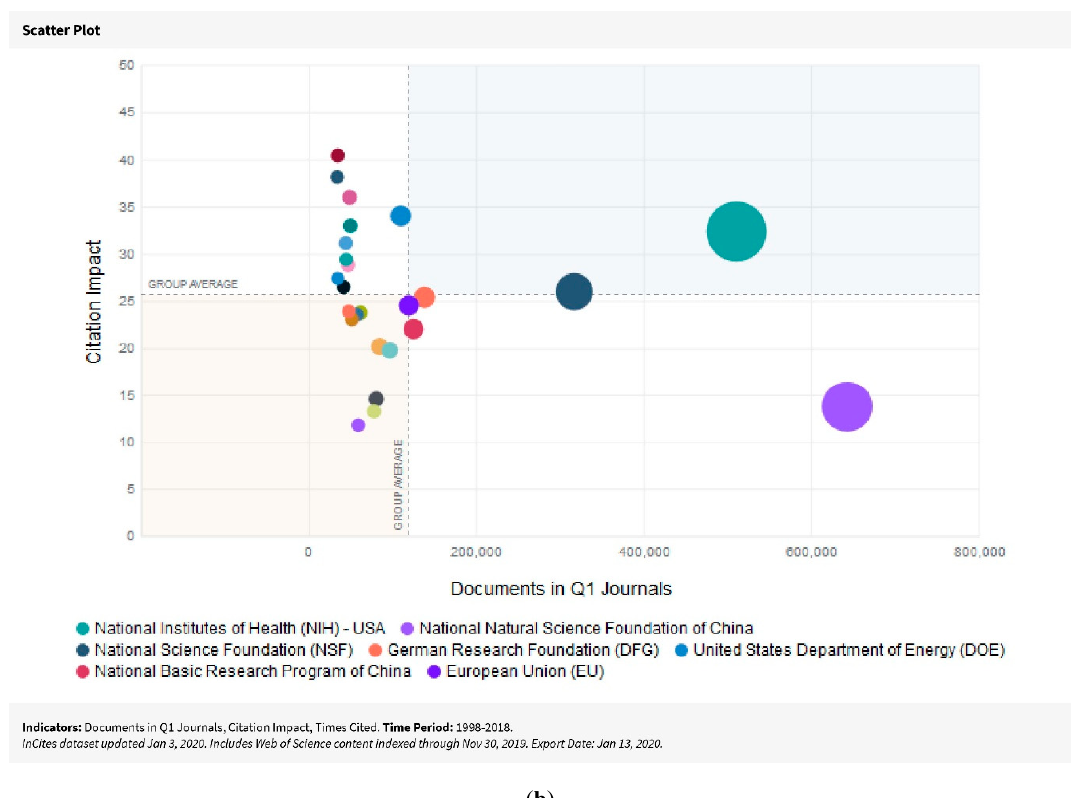
Figure 6. ( a ) Top 25 OMSAMC Funding Agencies and Record Count. ( b ) InCites Top 25 Funding Agencies and Record Count.